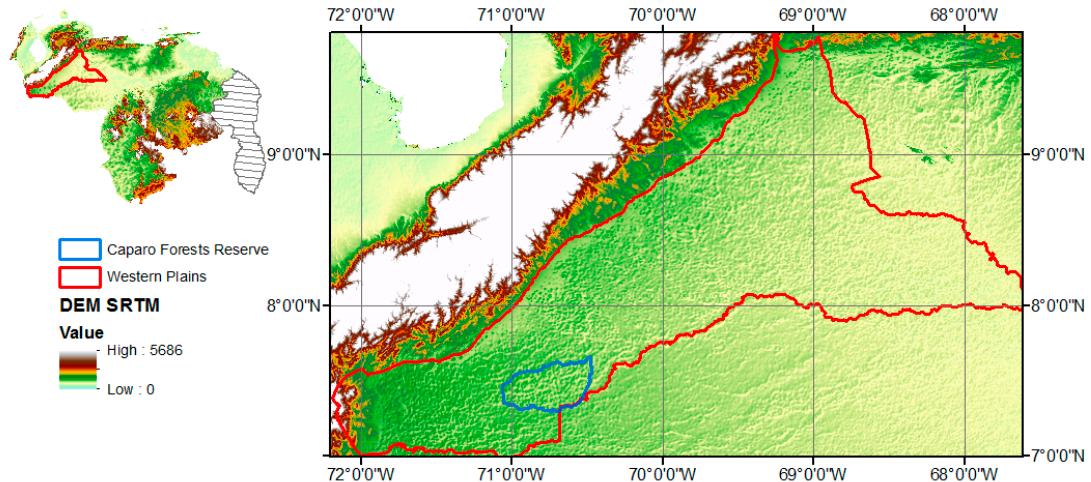
Figure A1. Location of the study area within DME from NASA’s Shuttle Radar Topography Mission (SRTM) [93].